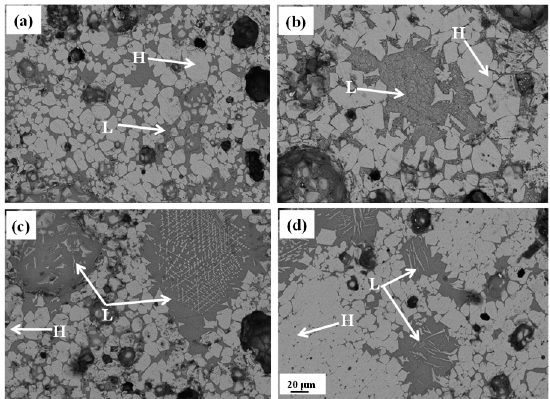
Figure 15. The effect of SiO 2 on liquid phase when SiO 2 is ( a ) 4%, ( b ) 6%, ( c ) 8%, and ( d ) 10%. L: Liquid phase; H: Hematite.